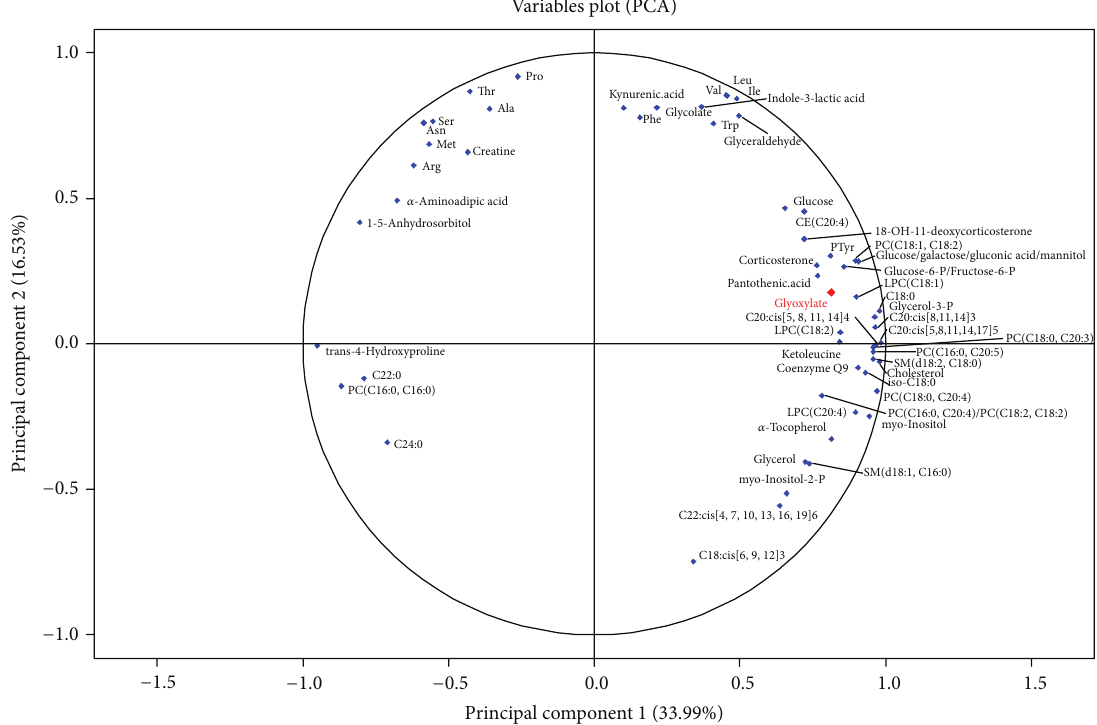
Figure 3: Variables plot showing plasma metabolites responsible for separation of individual mice. To visualize the strongest separators only, square correlations from both dimensions are summed for all metabolites and metabolites with a minimal sum of 0.6. The more distant the metabolitesarefromthecirclecenter,thehigherthecorrelationwiththedimension(PC:phosphatidylcholine,LPC:lysophosphatidylcholine)